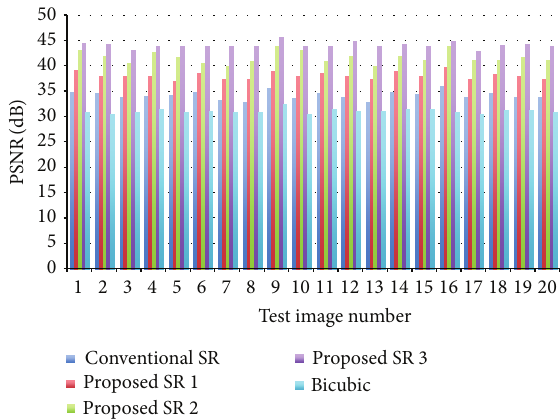
Figure 8: PNSR of 20 test images (MaVIC) by different methods.